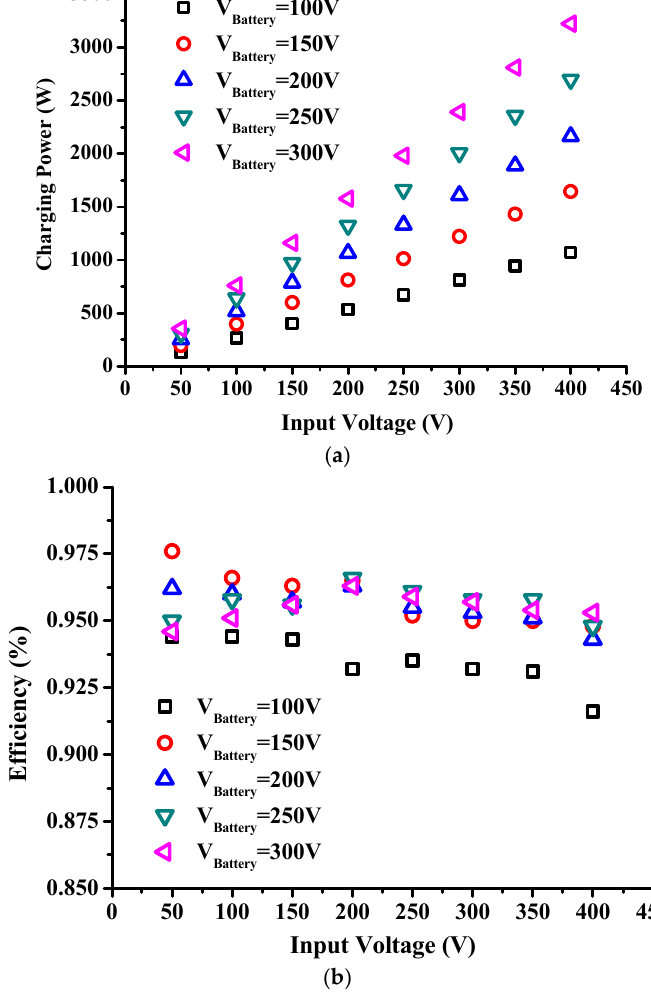
Figure 13. Wireless transfer power ( a ) and efficiency ( b ) at different input voltages and battery pack voltages at 20 cm transfer distance.